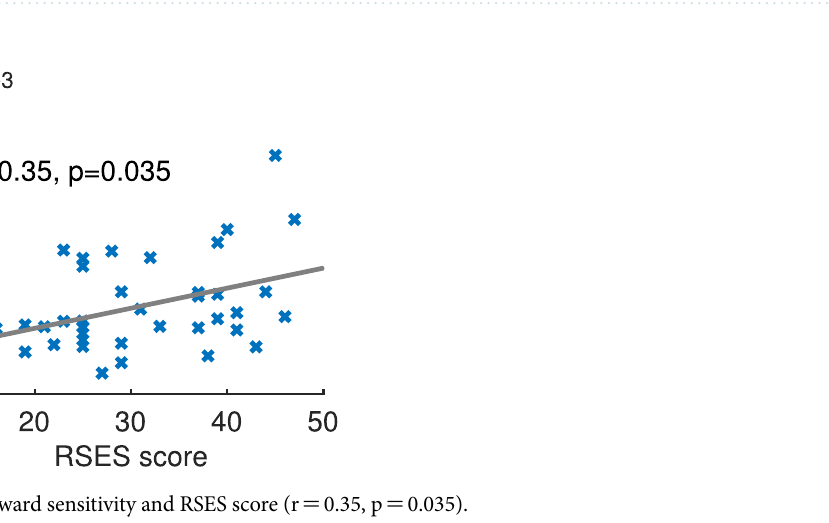
Figure 2. Decisions of each condition. Empirical cumulative distribution functions for ratios of choices of more ambiguous stimuli. The vertical axis represents the proportion of participants. ( a ) Decisions of C1 and C2. ( b ) Decisions of C2 and C3.